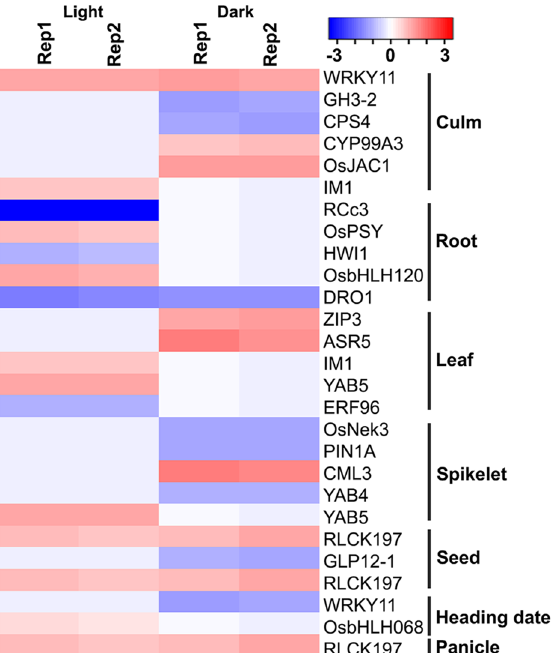
Figure 5. Organ-association of nitrate-responsive genes. The identified N-responsive DEGs were searched in Oryzabase database, catalogued and their expression presented as heat maps using heatmapper (https ://heatm apper .ca/). The default colour scale shows the expression value of DEGs (calculated as z-scores) associated with culm, root, leaves, spikelet, seed, heading date and panicle. Rep1, replicate 1; Rep2, replicate 2. The symbols of genes were according to